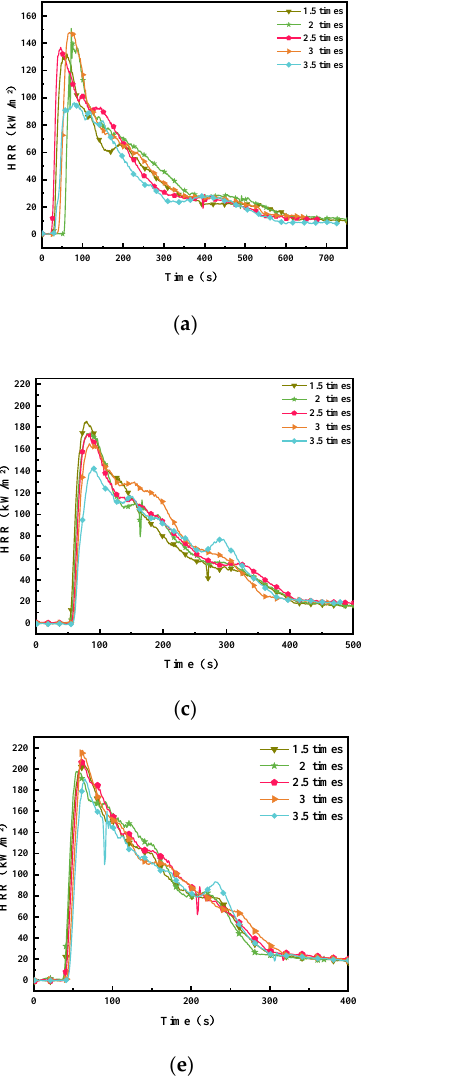
Figure 7. HRR for the wires at various external heat fluxes. ( a ): 25 kW m −2 ; ( b ): 30 kW m −2 ; ( c ): 35 kW m −2 ; ( d ): 40 kW m −2 ; ( e ): 50 kW m −2 .